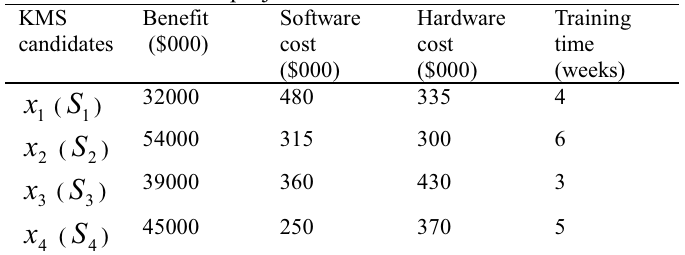
Table 4. KMS project towards resource